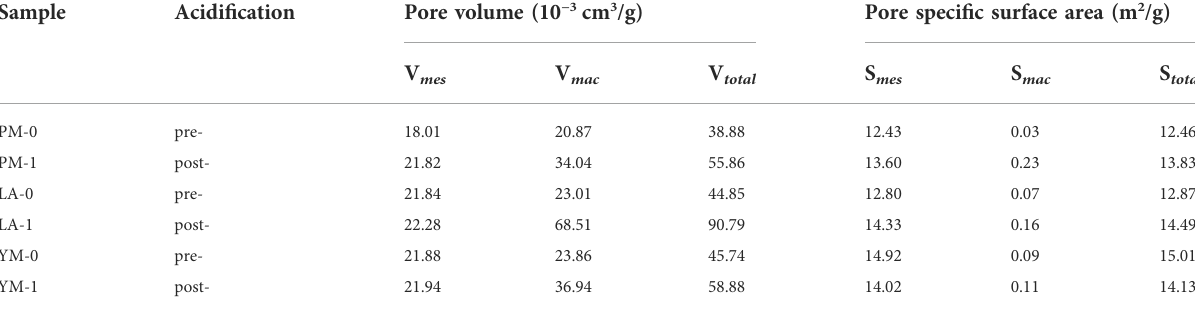
TABLE 3 Pore structural parameters of the raw and acidi fi ed coal samples from the MIP measurement a .